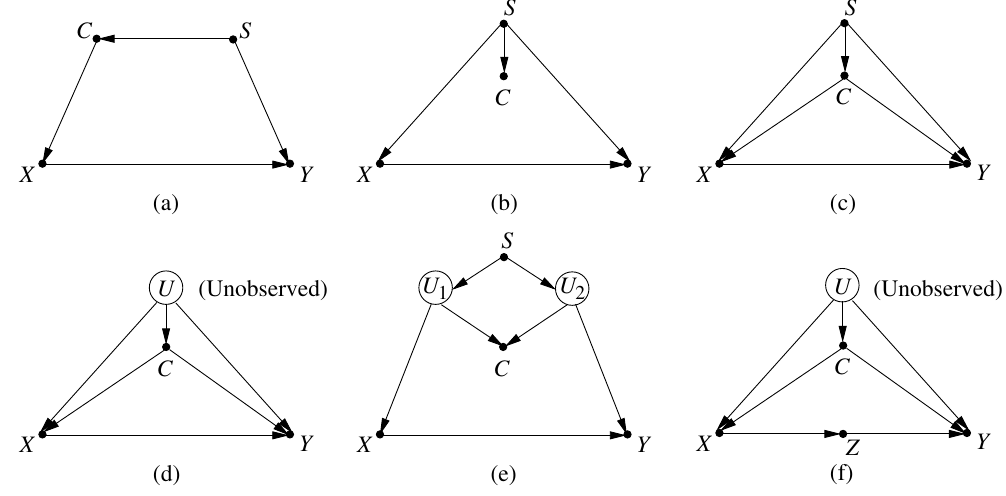
Figure 1: Models (a), (b), and (c) permit the identification of the c -specific effect of X on Y (by adjustment). Model (d) does not permit this identification, lacking an admissible set. Model (e) does not permit the identification of c -specific effects, even though S is admissible. Model (f) permits the identification using measurement of Z though S is admissible ( U and U are 1 2